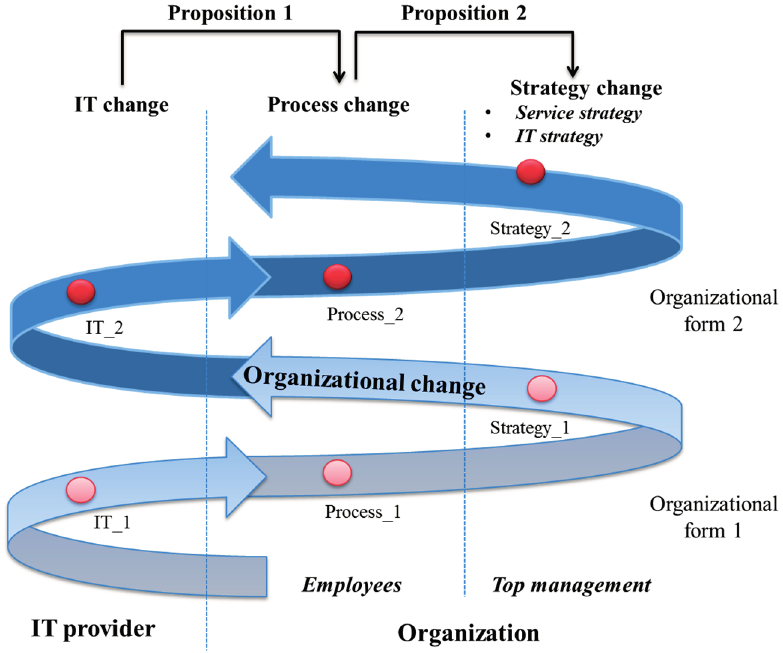
Figure 3. Proposed research